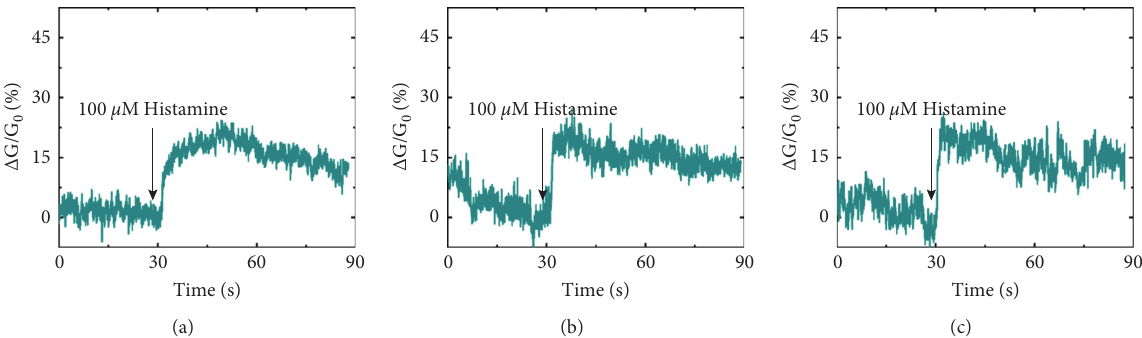
Figure 4: Repeated measurement of the real-time electrophysiological responses of individual HeLa cells under the simulation of 100 μ M histamine measured by using a single SCN device.